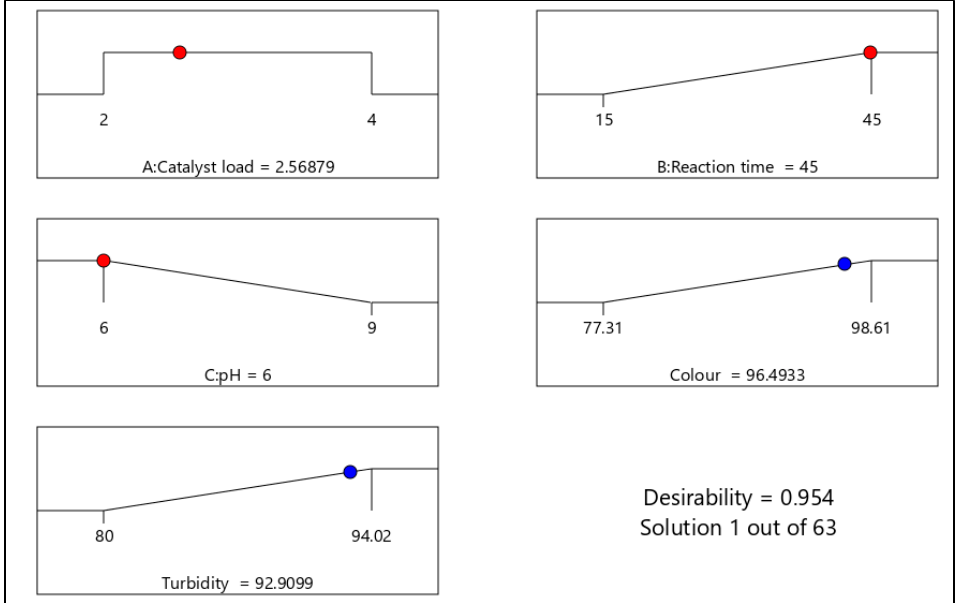
Figure 7. Ramp plot of numerical optimized conditions with the desirability of